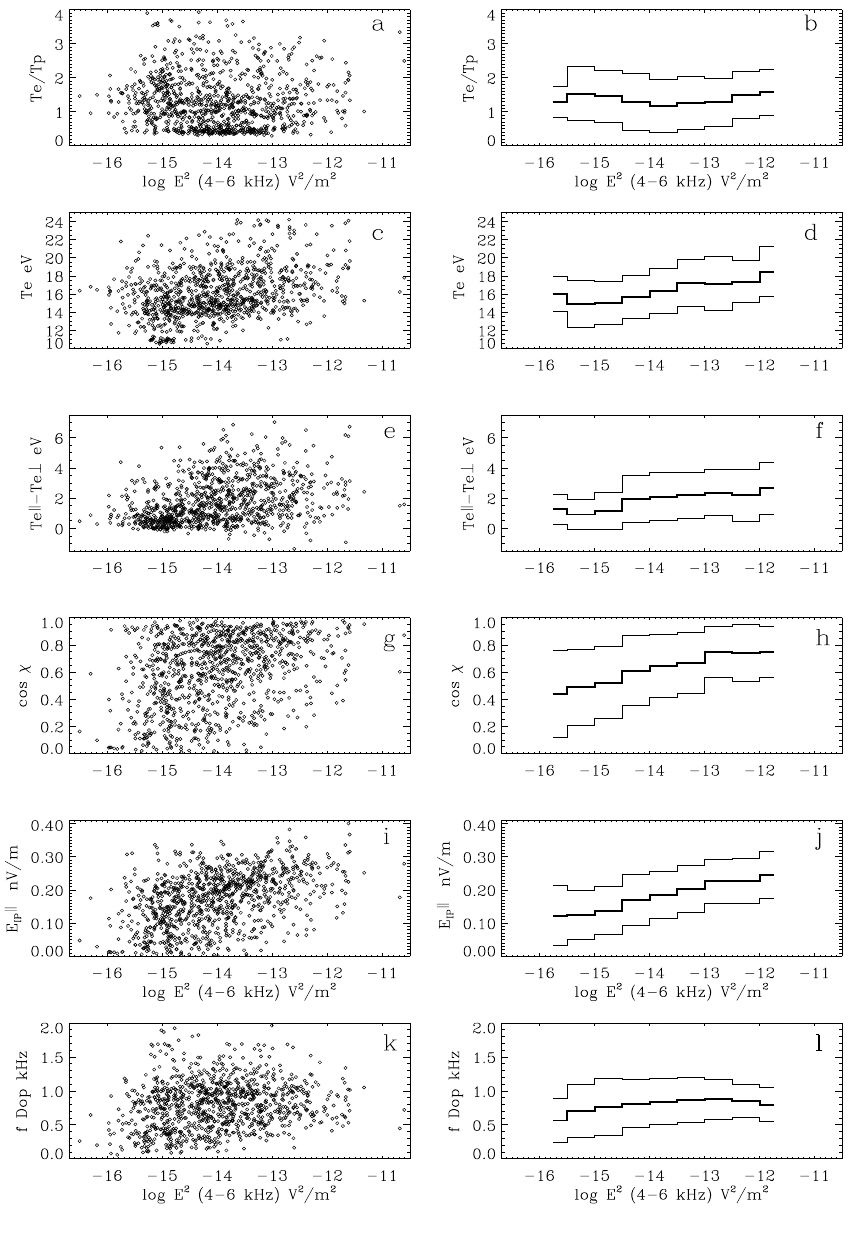
Fig. 6. In the free solar wind (not connected to the Earth’s bow shock), hourly averages of solar wind parame- ters as functions of the hourly energy E 2 in non-thermal ion acoustic waves between 4 and 6kHz. Left-hand pan- els: scatter plots. Right panels: av- erage and standard deviation in equal bins of log E 2 . Ordinates: (a) and (b) the temperature ratio T e /T p ; (c) and (d) the electron temperature; (e) and (f) the electron temperature anisotropy; (g) and (h) the cosine of the acute angle be- tween the magnetic field and the radial direction; (i) and (j) the interplanetary electric field parallel to the spiral mag- netic field in a two-fluid model (Eqs. 10 to 13); (k) and (l) the estimated Doppler shift of ion acoustic waves in the solar wind (Eq. 14). For E 2 , we have crudely corrected a bias due to the dipole an- tenna response for small wavelengths (see Sect.